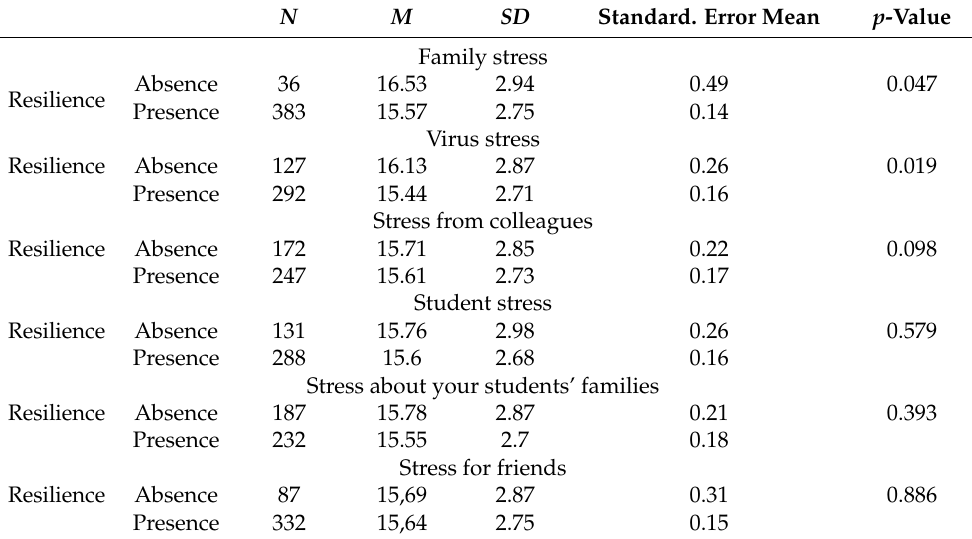
Table 2. Descriptive statistics and significance of Student’s t -test for resilience and stress associated with COVID-19.